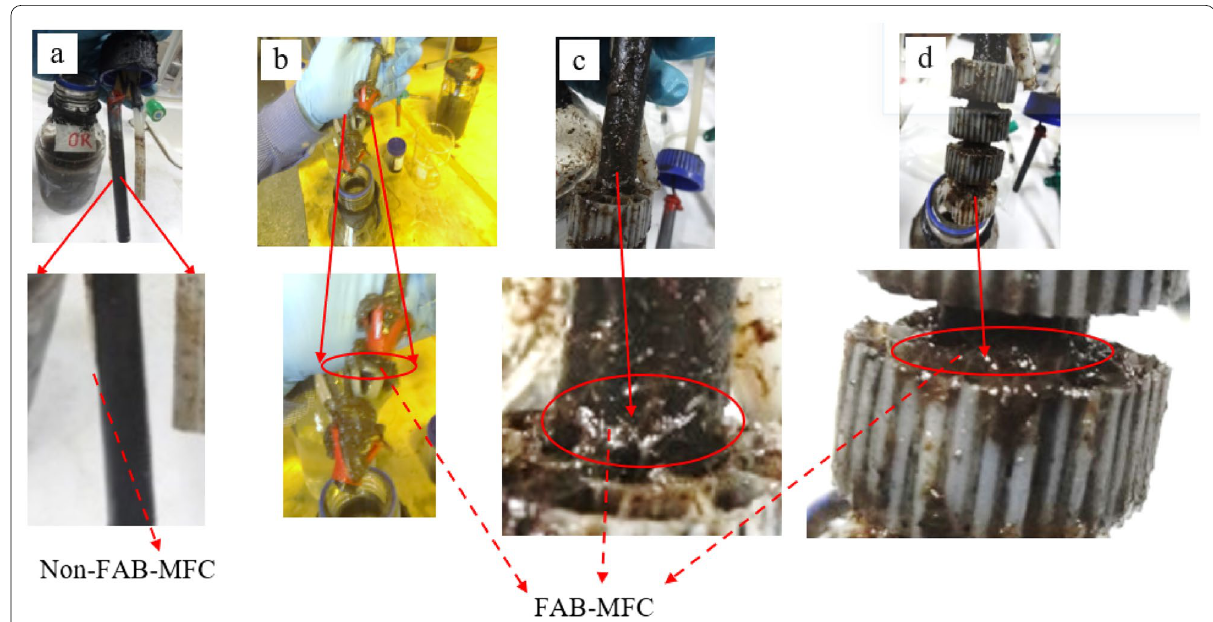
Fig. 6 Biofilm growth and development on a non-FAB-MFC, b 3D, c , d K3